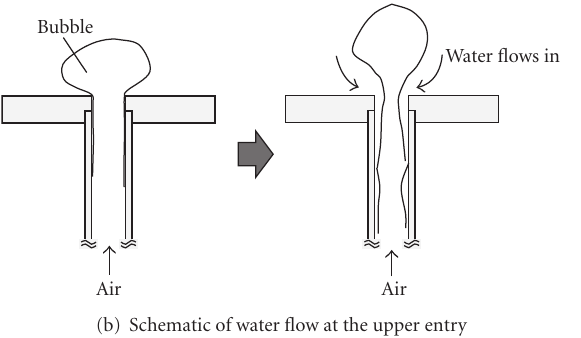
Figure 7: Video images of bubble “neck” at the upper entry of tube and sequence of water flow at the upper